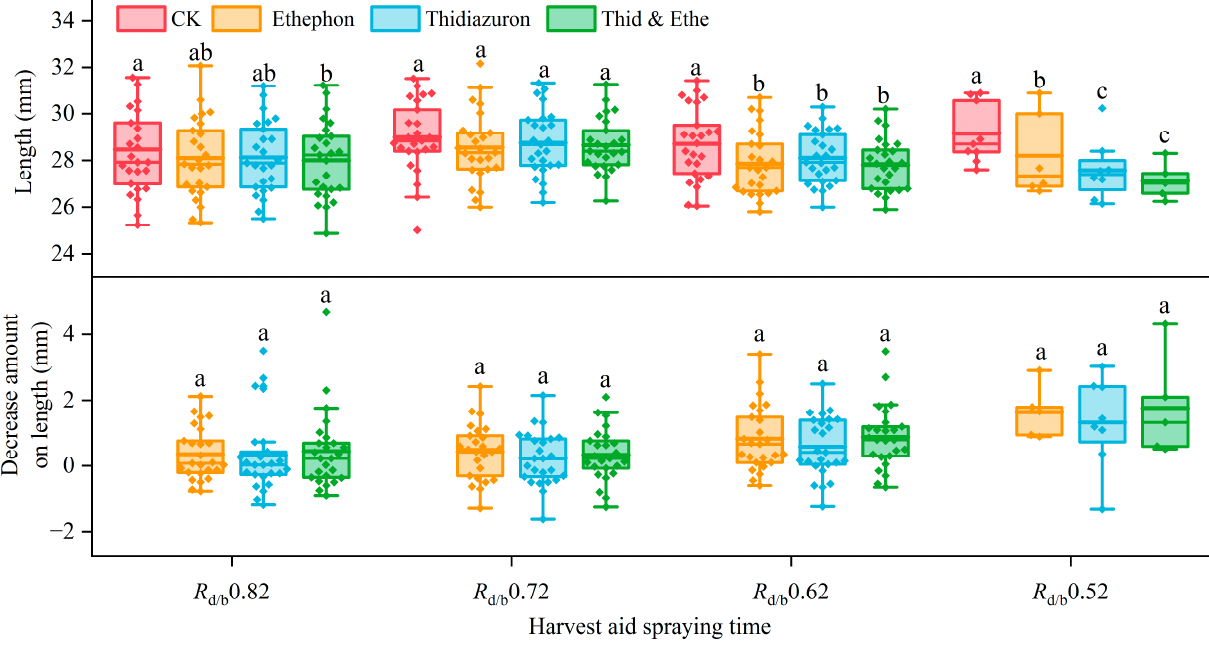
indicates the average value. The different letters indicate significant differences between harvest aid